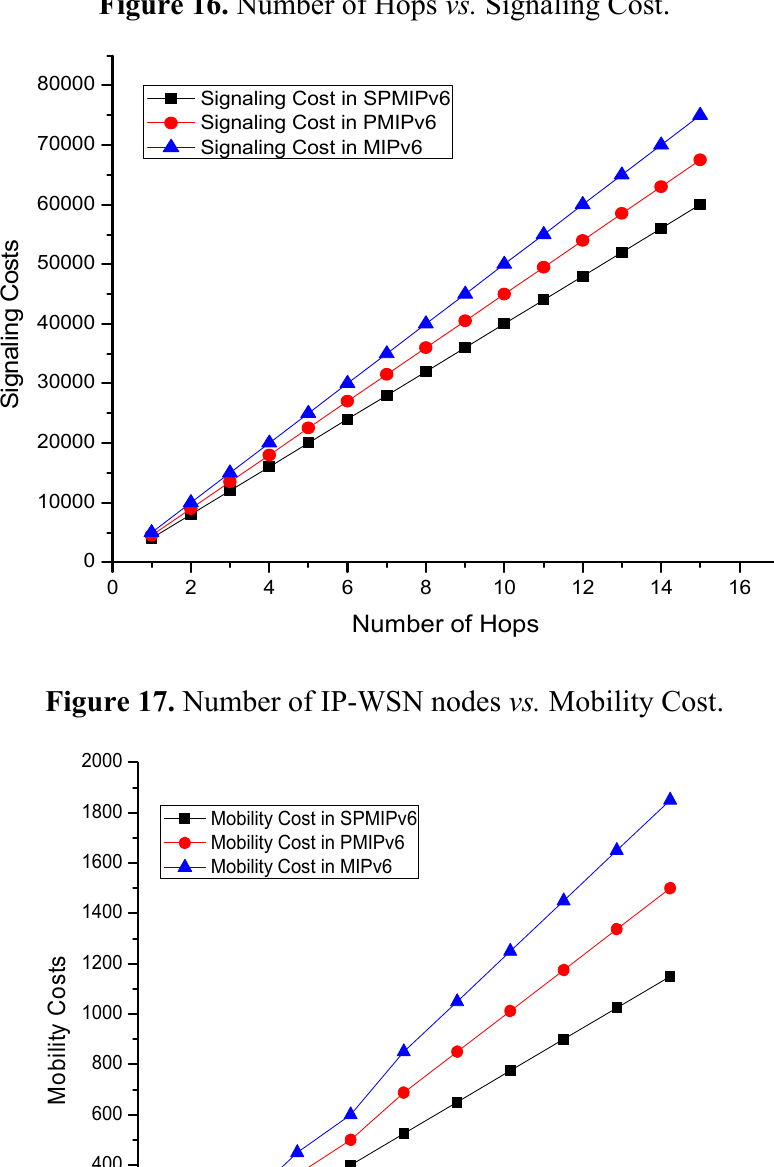
Figure 16. Number of Hops vs. Signaling Cost.